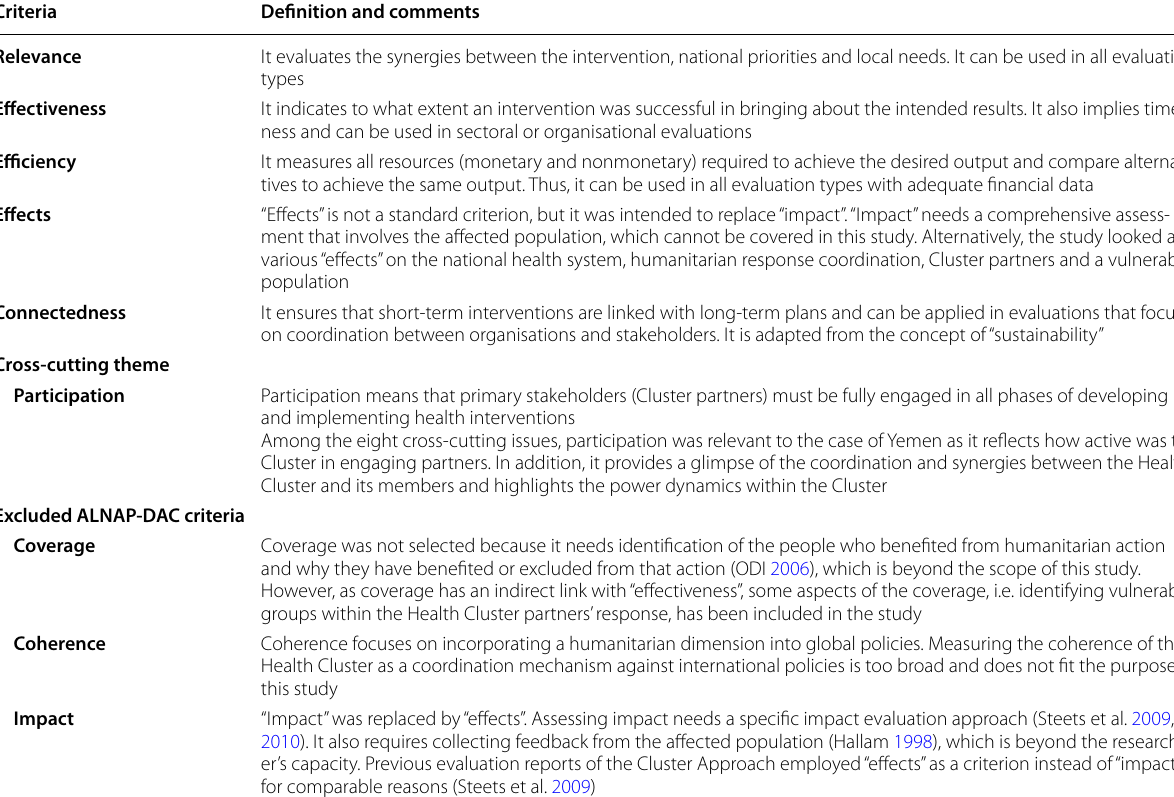
Table 2 Description of ALNAP‑DAC evaluation criteria used to design the study’s analytical framework (adapted from ALNAP guide 2006)